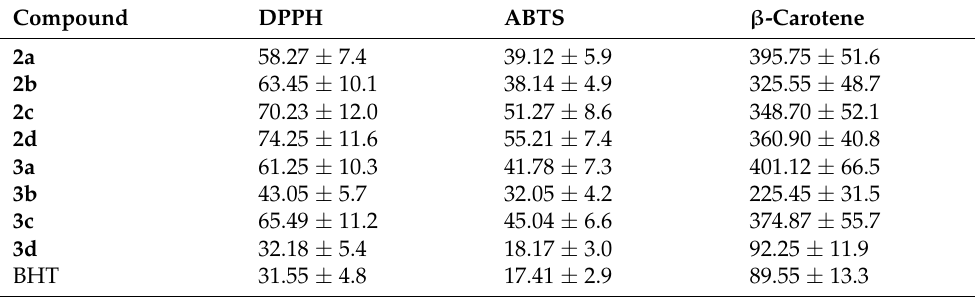
Table 2. Antioxidant activity of the synthesized compounds assessed by DPPH, ABTS antiradical scavenging power and β-carotene bleaching test presented by their IC 50 in μM mL −1 of mean ± S.D. Compound